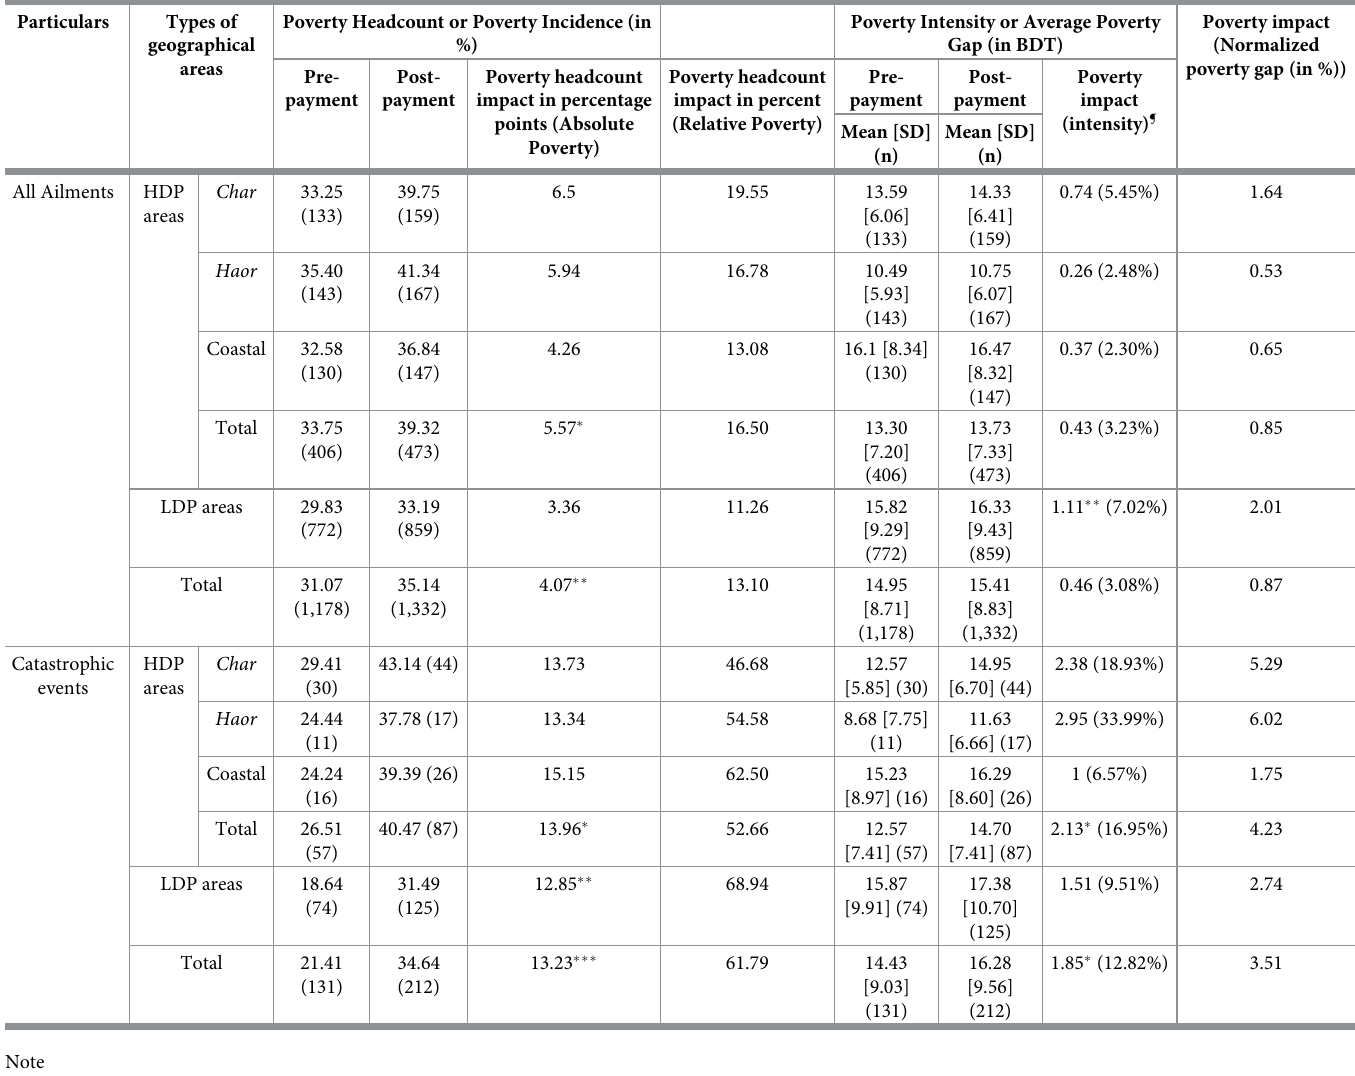
Table 5. Impact of OOP payments on poverty for all ailments and catastrophic events by geographical areas.